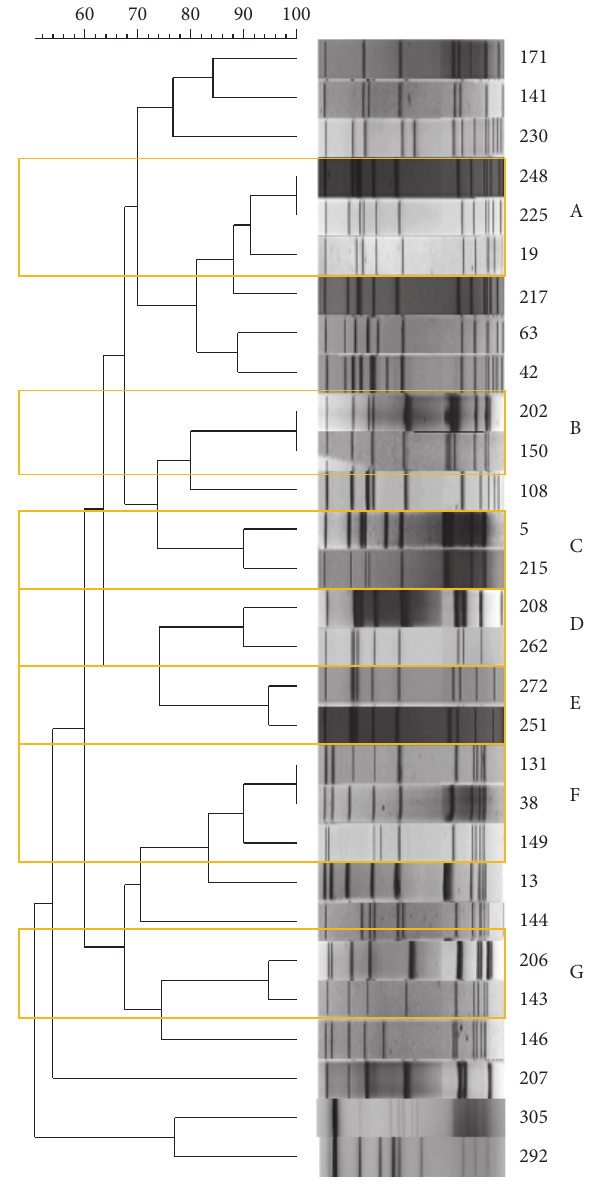
Figure 3: Asc I-PFGE restriction patterns of the 29 pregnancy- related isolates of L. monocytogenes , Lombardy, Italy, 2004–2015. Clusters with ≥ 90% similarity are highlighted by orange boxes and identified with a